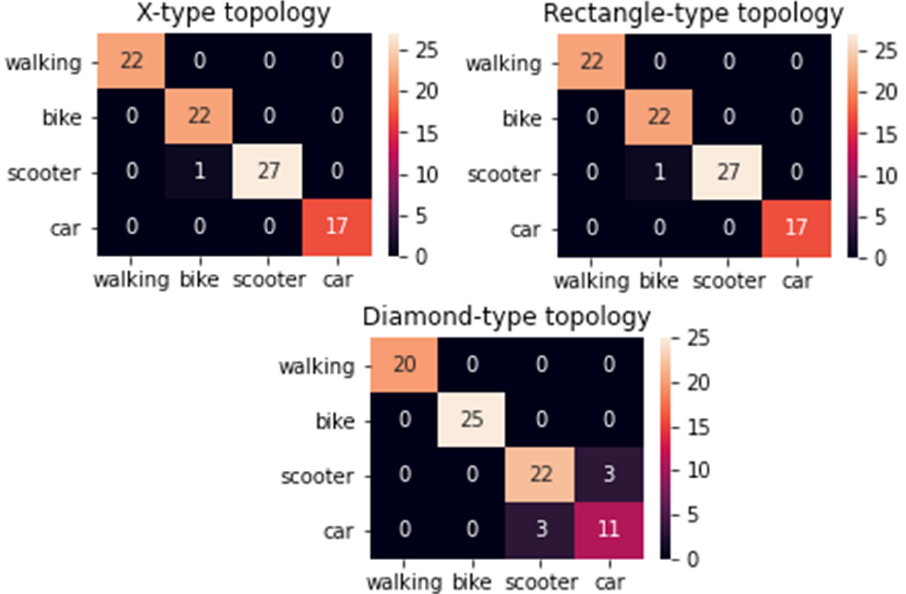
Figure 10. Confusion matrixes of three topologies for BT.